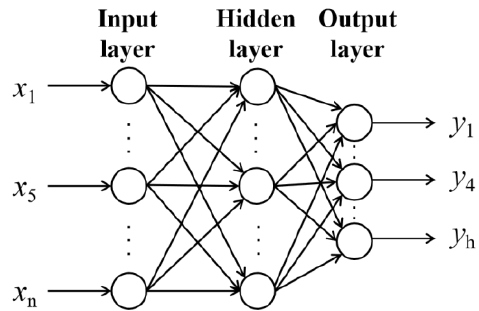
Figure 3. BP neural network